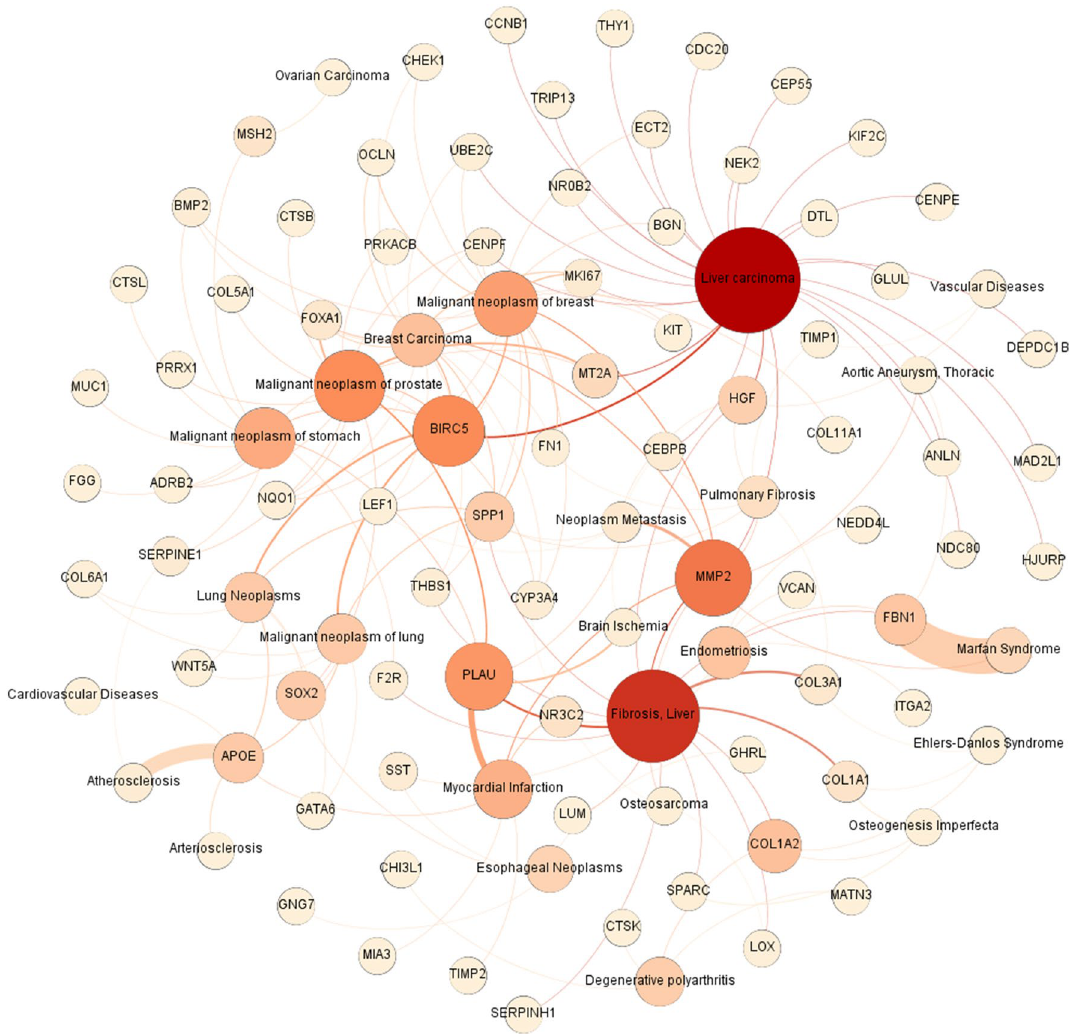
Figure 5. Gene-disease network. It shows not only the diseases and syndromes that have common genes and pathways with gastric adenocarcinoma, but also the common genes participating in different diseases and syndromes. Node size represents the degree (the bigger size shows the higher degree). The node color exhibits betweenness (the darker color indicates the higher